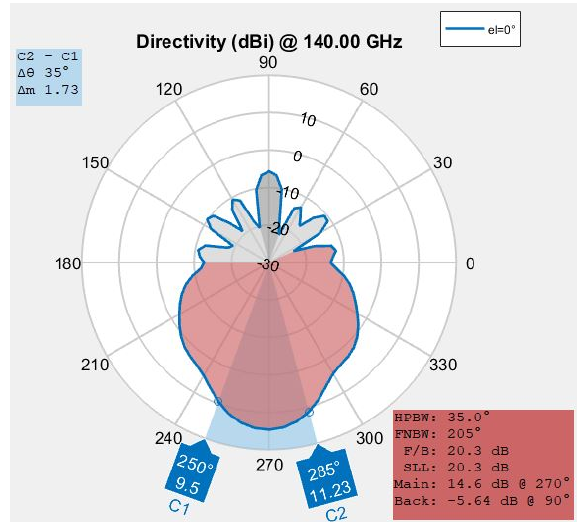
Figure 24. Azimuth pattern (directivity) of Horn antenna.